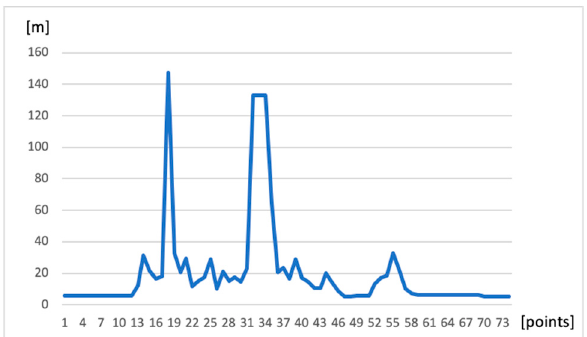
Figure 6. Examples of horizontal GPS errors while walking. The duration from the 10th point to the 58th point shows that a user had remained indoors.